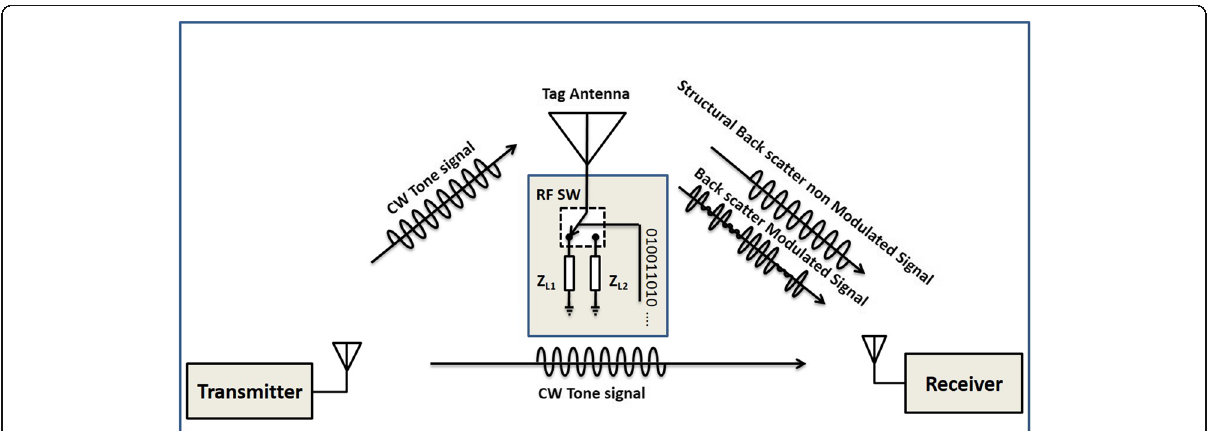
Fig. 1 Illustration of backscatter communication system. The data alters differential radar cross section ( Δ RCS) of the tag device that results in backscatter signal